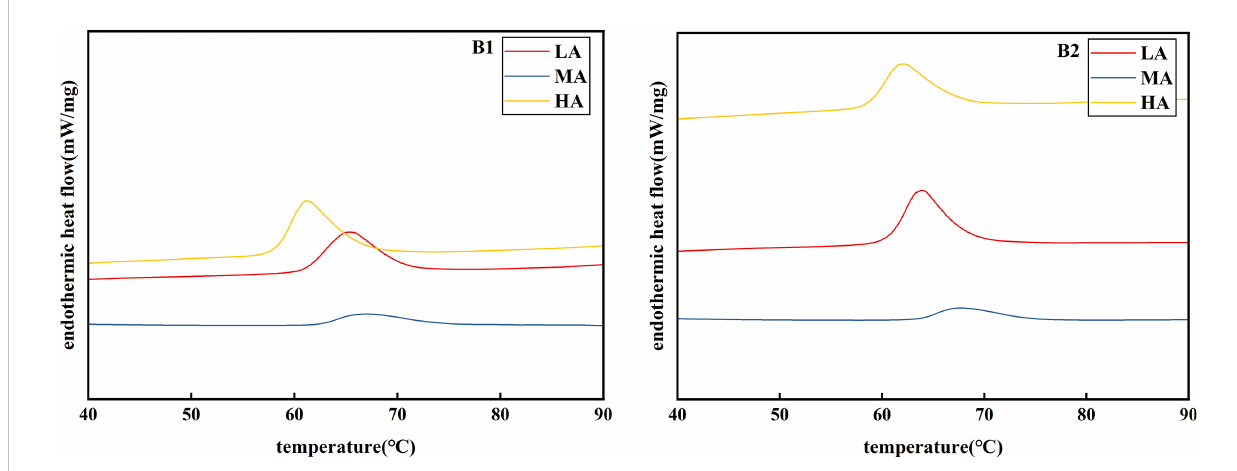
FIGURE 10 DSC endothermic curves of potato starch at different altitudes. Principal component analysis of starch indexes at different altitudes. LA (low altitude), MA (middle altitude) and HA (high altitude stand for Chongzhou, Xichang and Litang respectively; B1 and B2 stand for Jiusen No. 1 and Qingshu No. 9